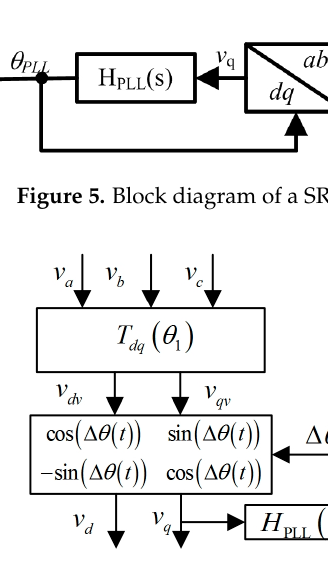
Figure 6. Block diagram of a decomposed SRF-PLL.